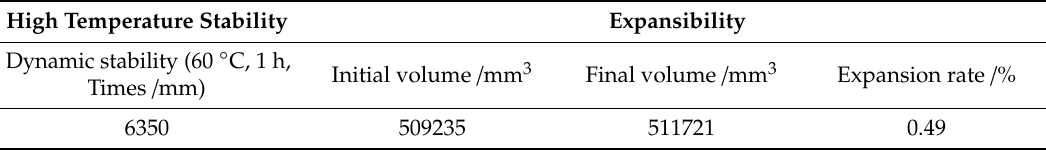
Table 2. Test results of the high temperature stability and expandability.